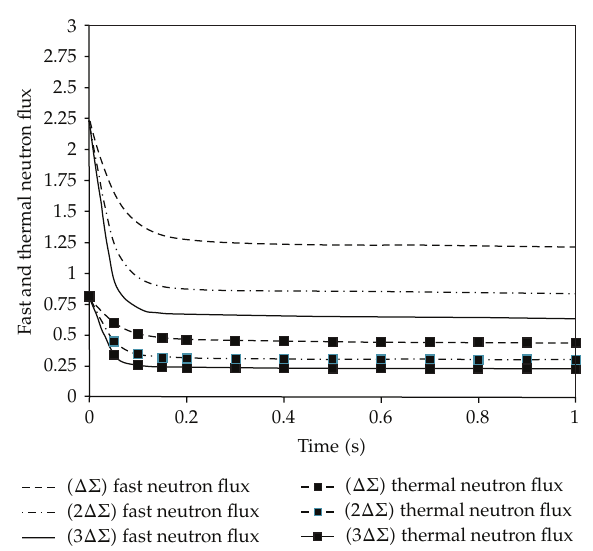
Figure 2: Fast and thermal neutron flux at a negative step reactivity.